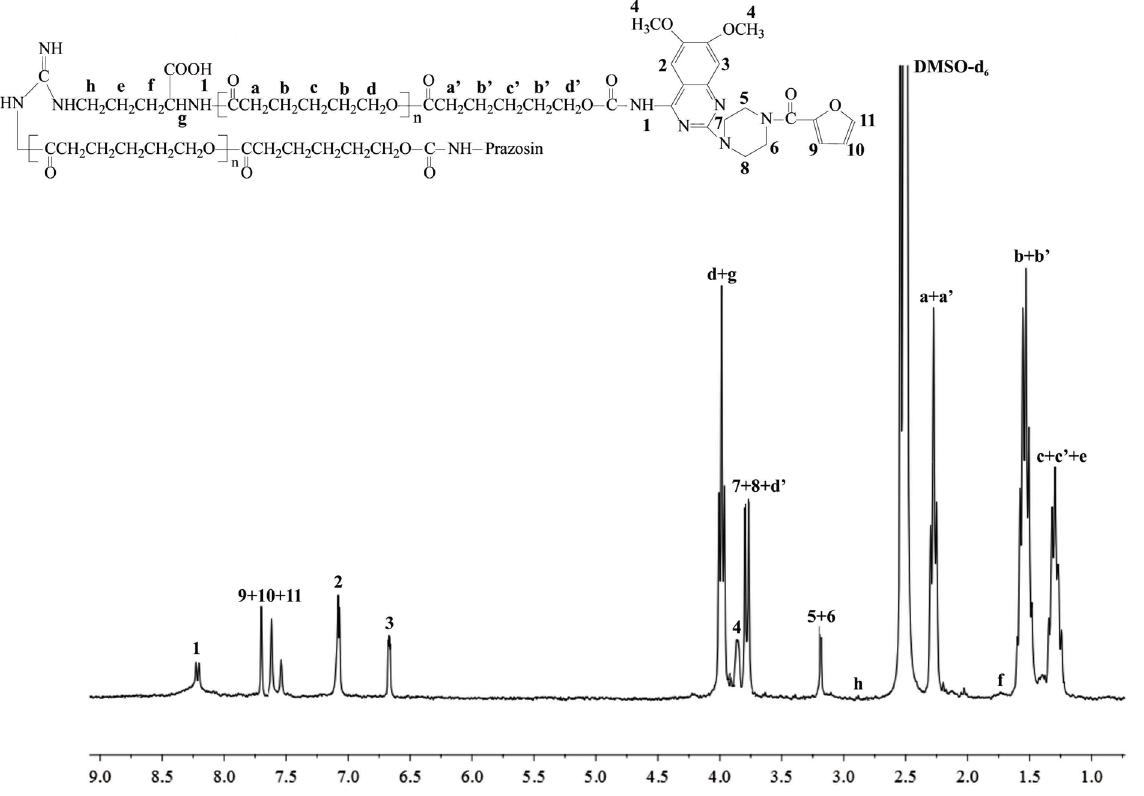
Figure 1. 1 H-NMR spectrum of the prazosin–PCL/Arg